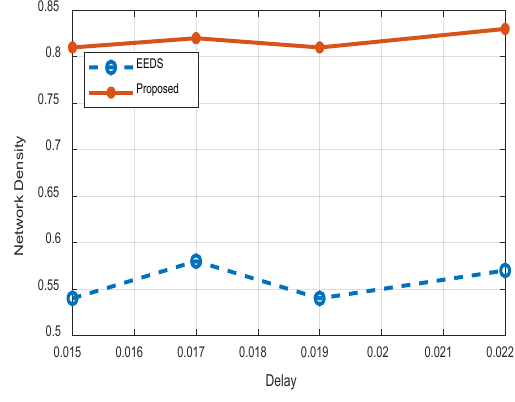
Figure 16. Network Density versus Delay